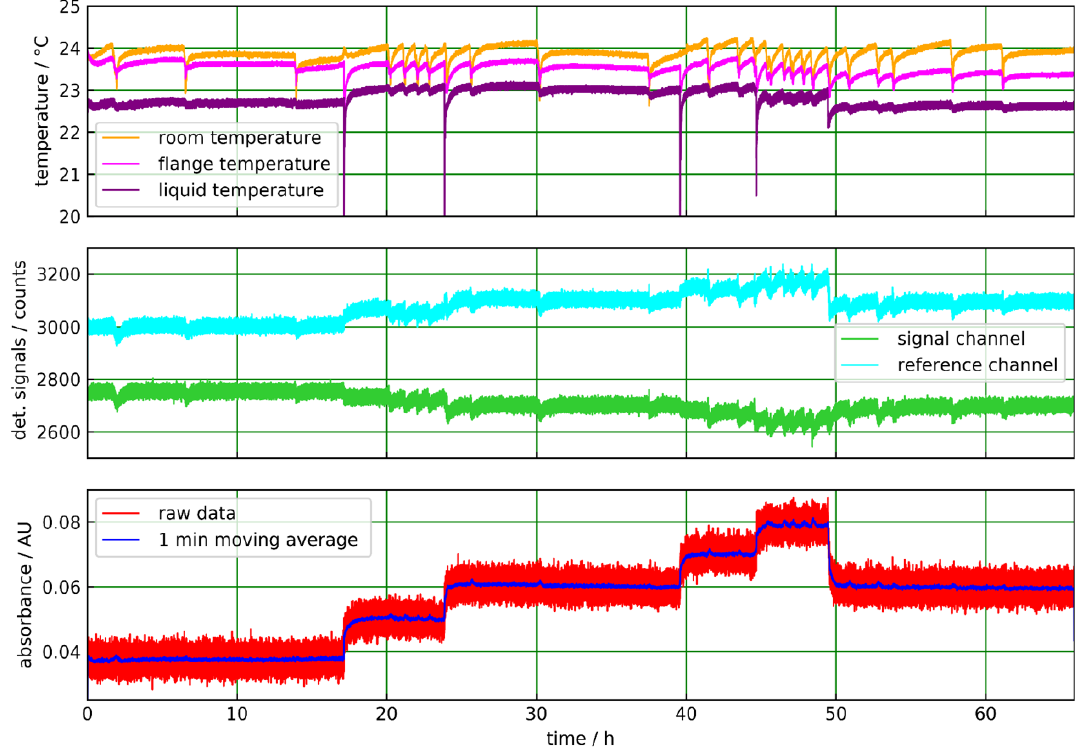
Figure 10. ATR measurement of acetonitrile in isopropanol with the sapphire tube in reflection geometry. Ambient and flange temperatures show distinct dips, which occurred when some liquid was added to the sample reservoir ( top ). The signal and reference channel data are hardly affected by these events. The concentration steps (0%, 5%, 10%, 15%, 20% (m/m) acetonitrile in isopropanol) are clearly visible in the signal channel but also in the reference channel, which shows an increasing level at higher acetonitrile concentrations ( middle ). In the absorbance plot the concentration steps are clearly resolved. Noise is efficiently reduced by a 1-min moving average ( bottom ).